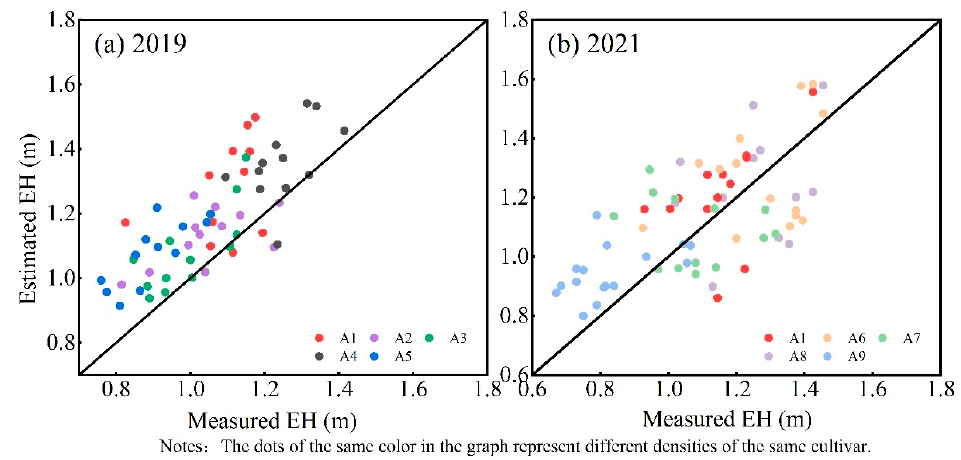
Figure 12. Filling period plot-scale EH estimates from TLS data for different cultivars ( a ) in 2019 and ( b ) in 2021. Table 9. EH overestimation using TLS data for di ff erent cultivars.